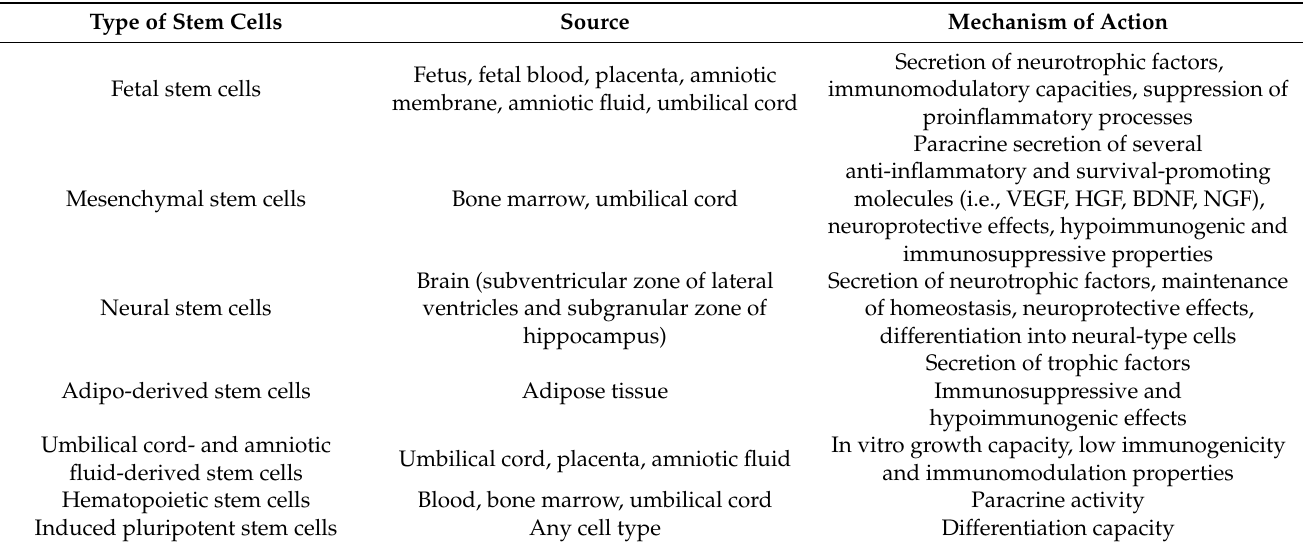
Table 1. Different stem cells, related sources, and their mechanisms of action [60–70,72–78,81,83,90].